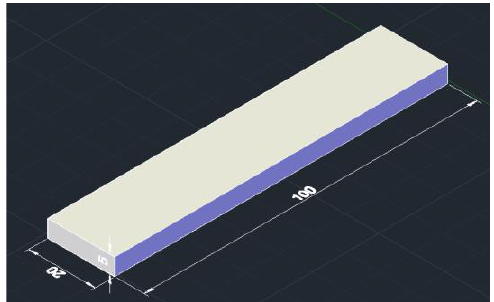
Figure 15. Sample model 1.